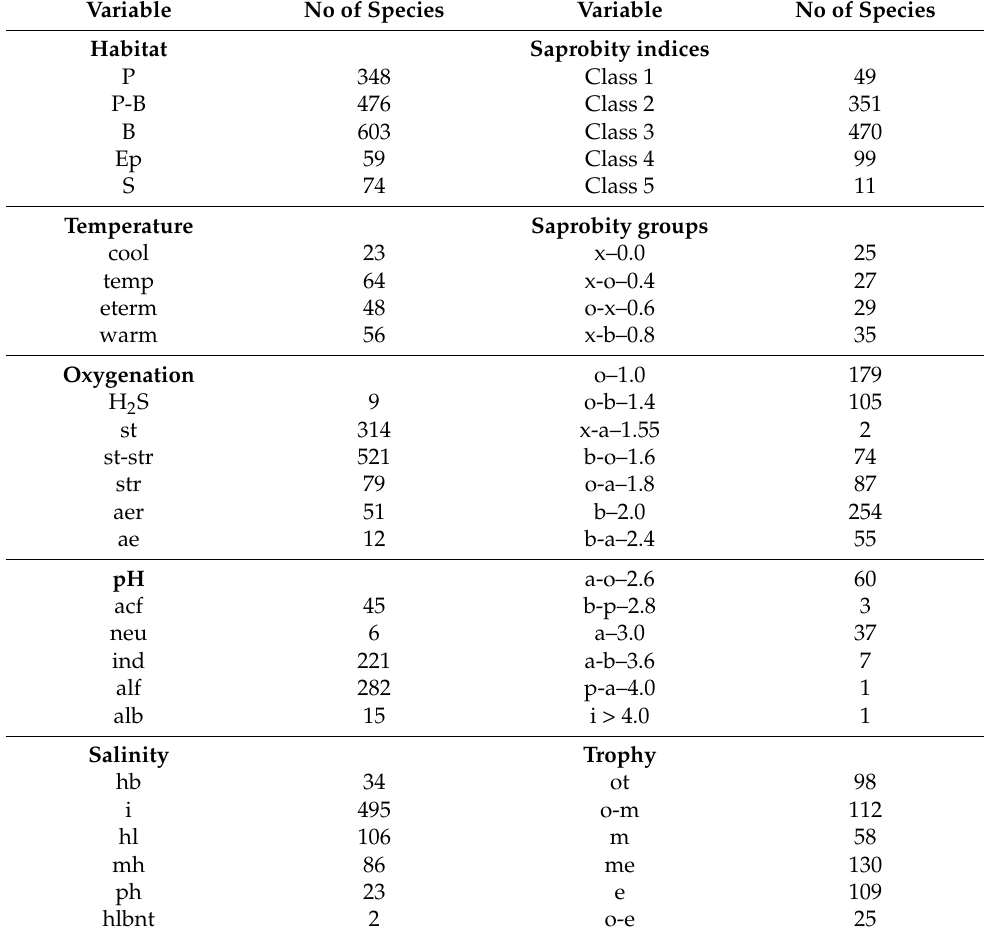
Table 3. The number of indicator species of algae and cyanobacteria in water habitats of Israel by ecological groups for the indicated environmental variables (bold). The ecological groups in each indicated parameter of the environment are arranged in order of increasing value of the indicated